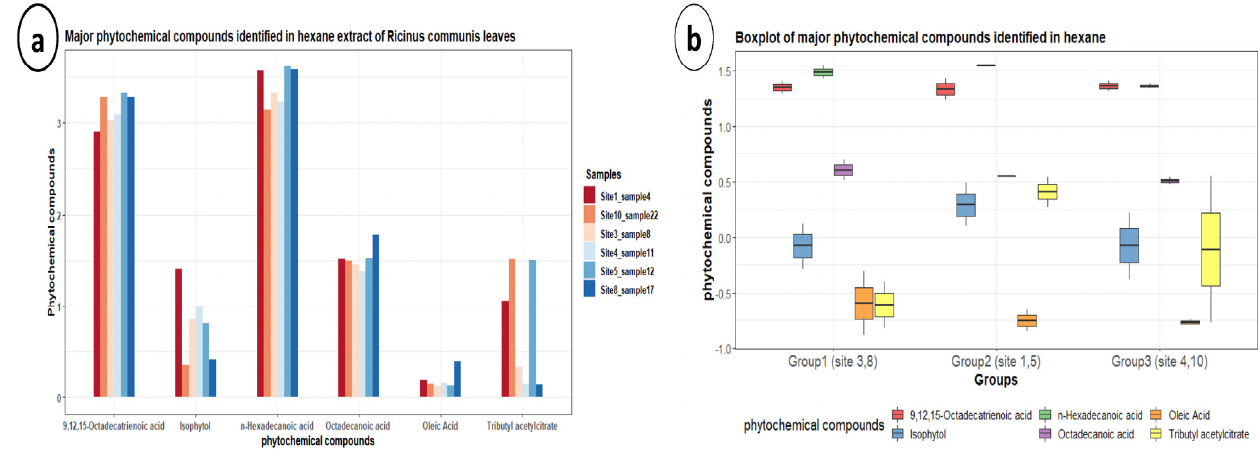
Figure 9. ( a , b ) Bar plots and boxplots for major phytochemical compounds identified in hexane extract of Ricinus communis per site and for groups.